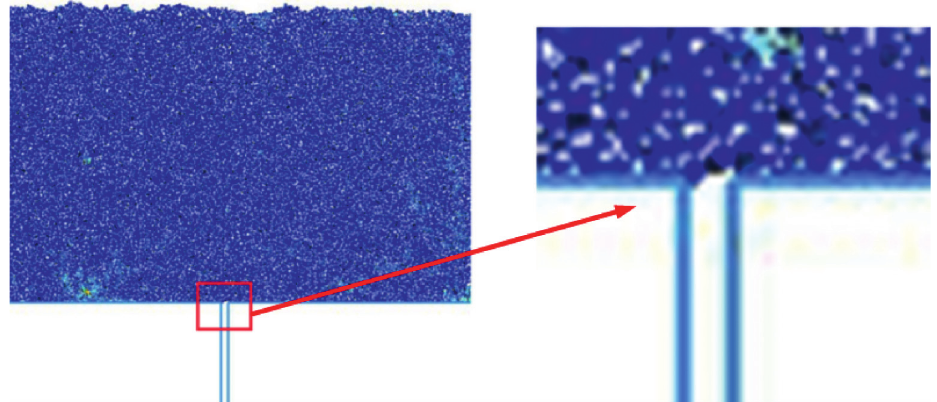
Figure 14: Stress arch in 0.8–90 model sand inrush